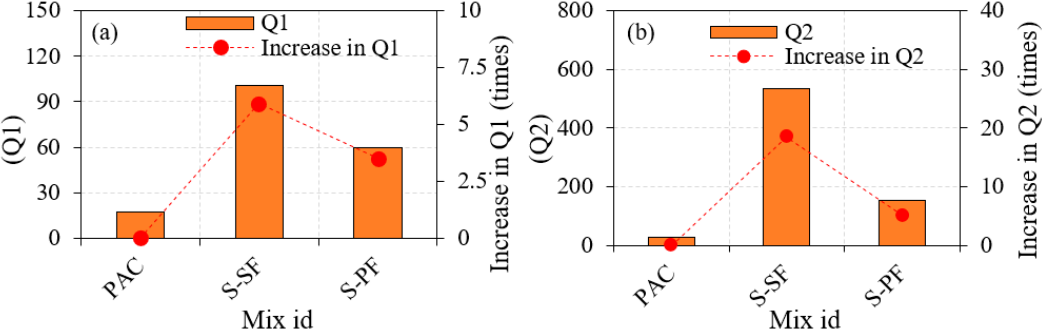
Figure 7. Impact strength of a single-layered specimen.